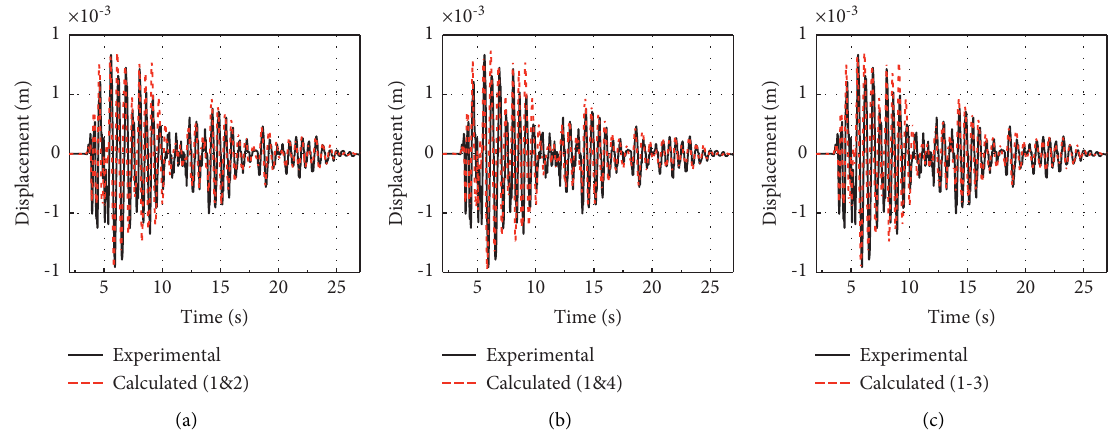
Figure 16: Displacement time histories of the first story by using different damping models (case 221): (a) RD with 1&2 frequencies of the isolated structure, (b) RD with 1&4 frequencies of the isolated structure, and (c) NP-CD with 1–3 frequencies of the nonisolated